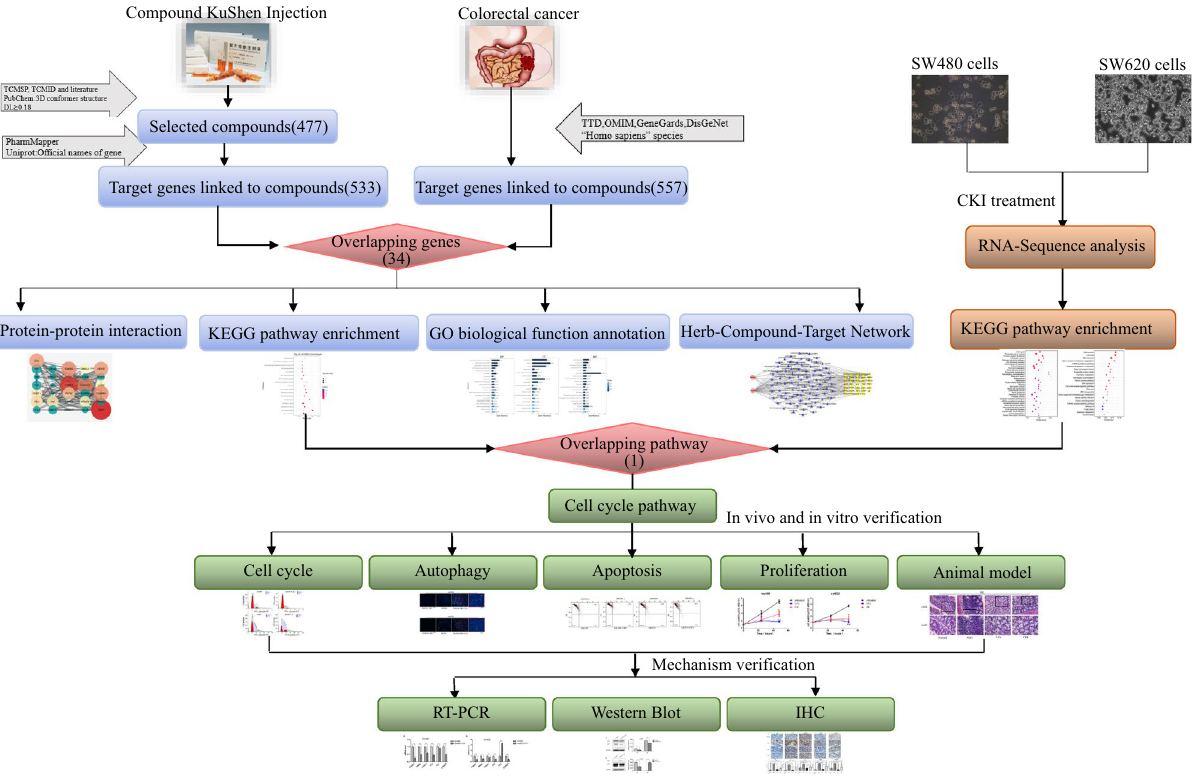
Figure 1. Workflow of network pharmacology and experimental validation